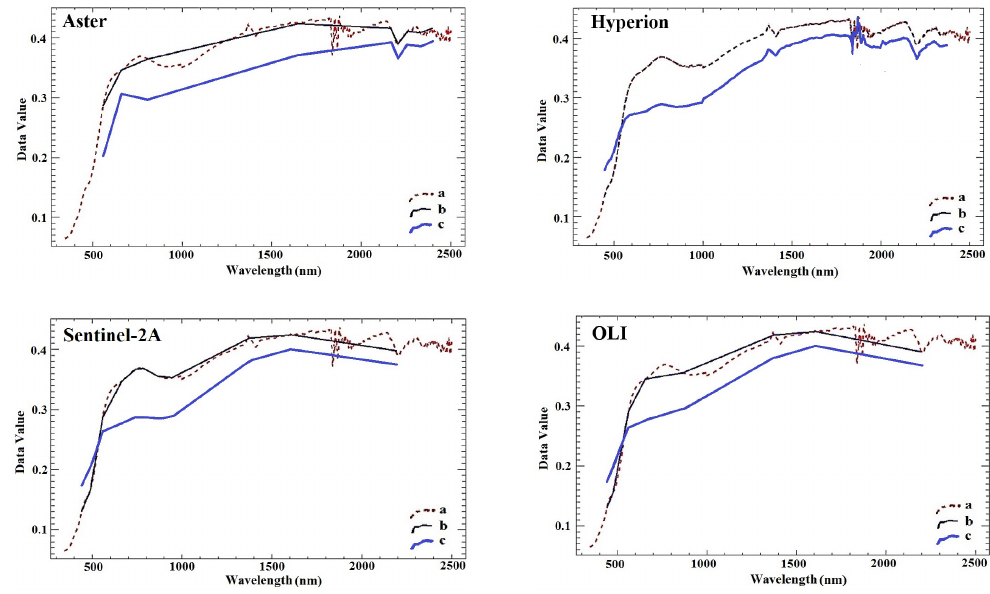
Figure 9. Full laboratory spectra of a randomly selected sample ( a ), sample’s spectra resampled to image bands ( b ) and the pixel’s spectra with the same location to the sample ( c